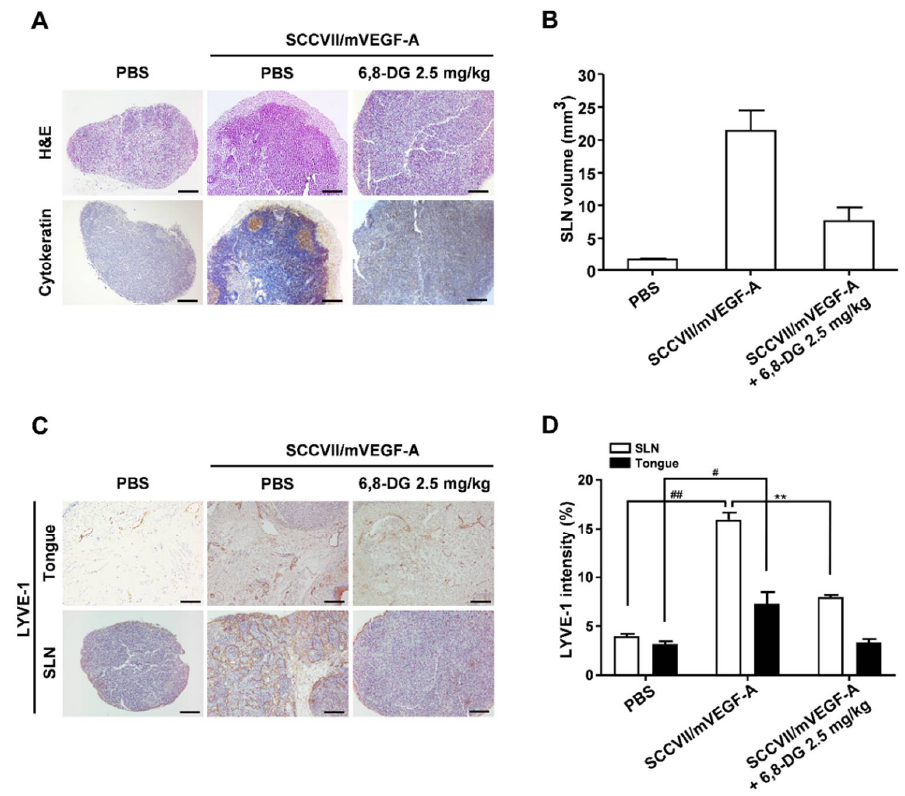
Figure 7. Effects of 6,8-DG on lymphangiogenesis and lymph node metastasis in a VEGF-A-induced OCSLN animal model. ( A ) Sentinel lymph nodes sections of mice of each group were analyzed using hematoxylin and eosin staining, and immunohistochemical analysis with anti-cytokeratin antibody. ( B ) Sentinel lymph nodes volumes were measured using a caliper. ( C ) Lymphatic vessel density values in sentinel lymph nodes sections were measured by immunohistochemical analysis using anti-LYVE-1 antibody. All sections were digitalized and images were captured under 200 × objective magnification. Scale bar = 200 µ m. ( D ) Immunohistochemical intensity values of LYVE-1 from captured images of tumors and sentinel lymph nodes were analyzed via the Image J program and represented as a bar diagram. Data are presented as a mean ± S.D. ( # p < 0.01, ## p < 0.001, ** p <